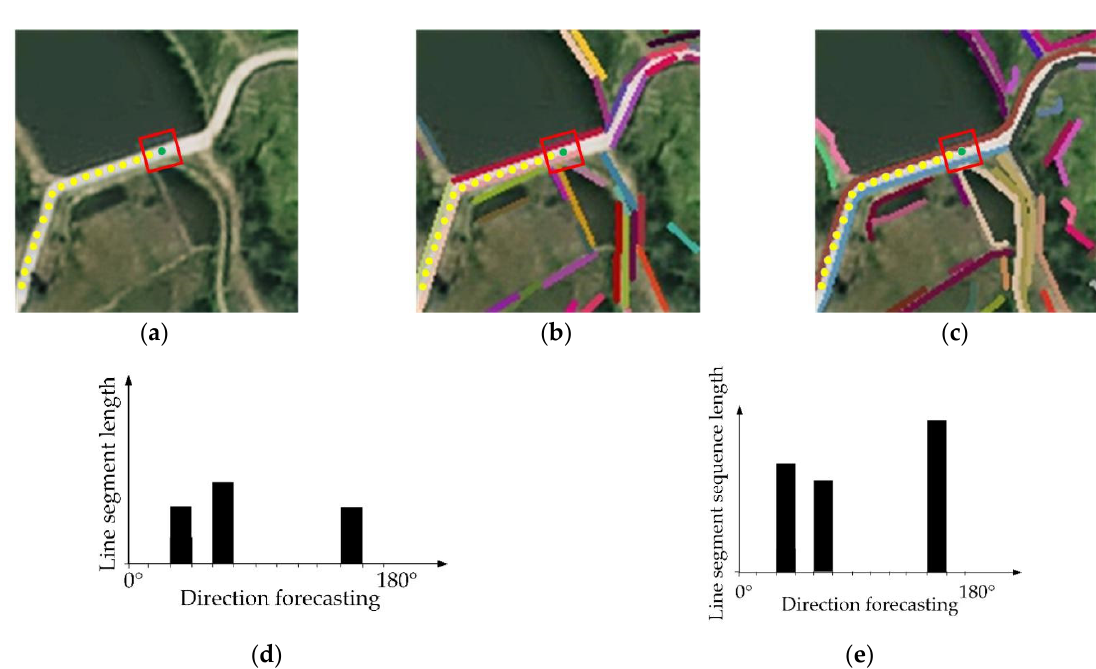
Figure 9. Multiscale line segment orientation histogram (MLSOH) model improvement demonstration. ( a ) Road seed point tracking image; ( b ) segment extraction results display; ( c ) line sequence results display; ( d ) MLSOH model prediction results; ( e ) road direction prediction results of this algorithm.